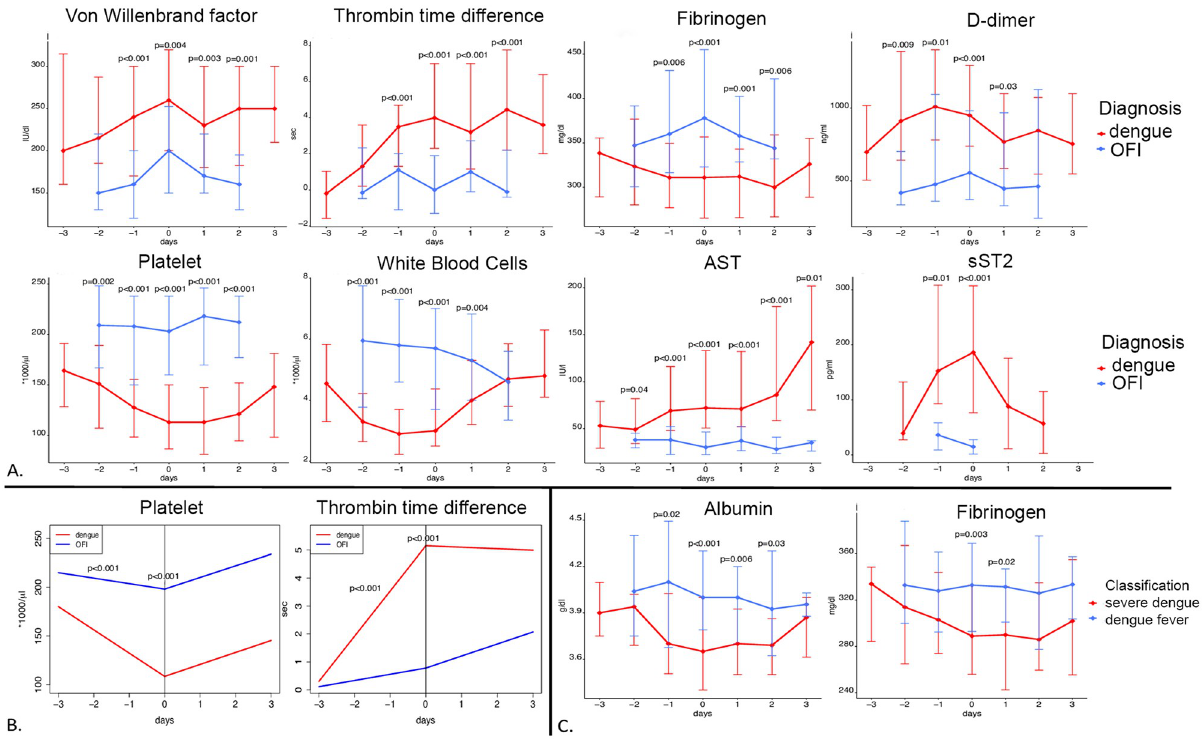
Fig 3. Evolution of selected blood biomarkers for selected groups comparison over the course of disease. A. Evolution of the medians (and interquartile ranges) with comparison between dengue and other febrile illness patients. B. Evolution of the biomarkers at patient level using piecewise linear mixed effects models with comparison between dengue and other febrile illness patients. C. Evolution of the medians (and interquartile ranges) with comparison between dengue fever and severe dengue patients. In A and C, the linking lines are displayed for a better visualization but do not represent the evolution of the biomarkers at patient level. D0 is the day of